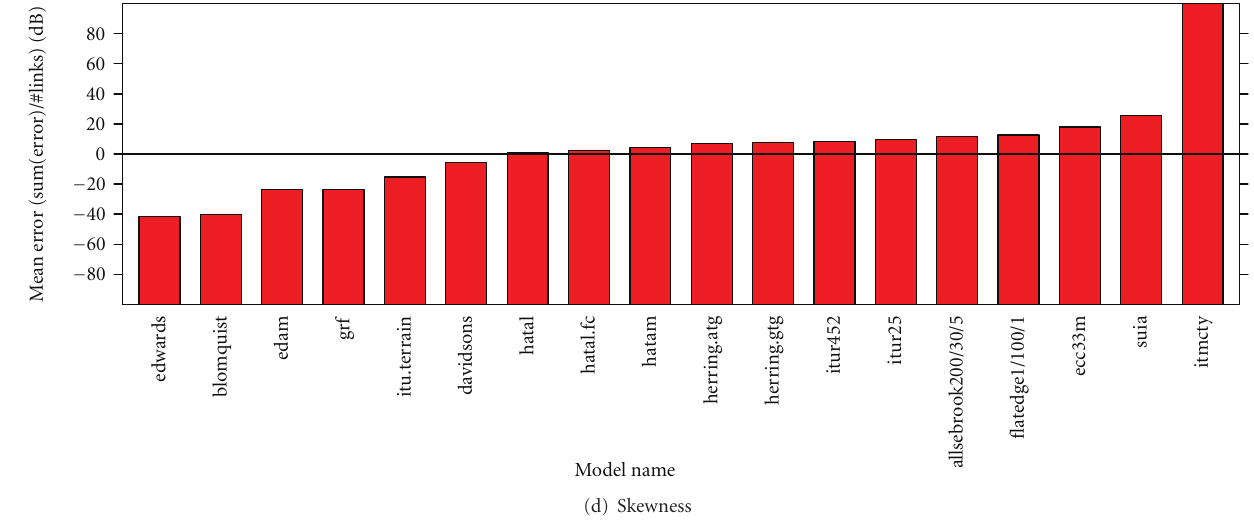
Figure 9: Five metric results for all data sets